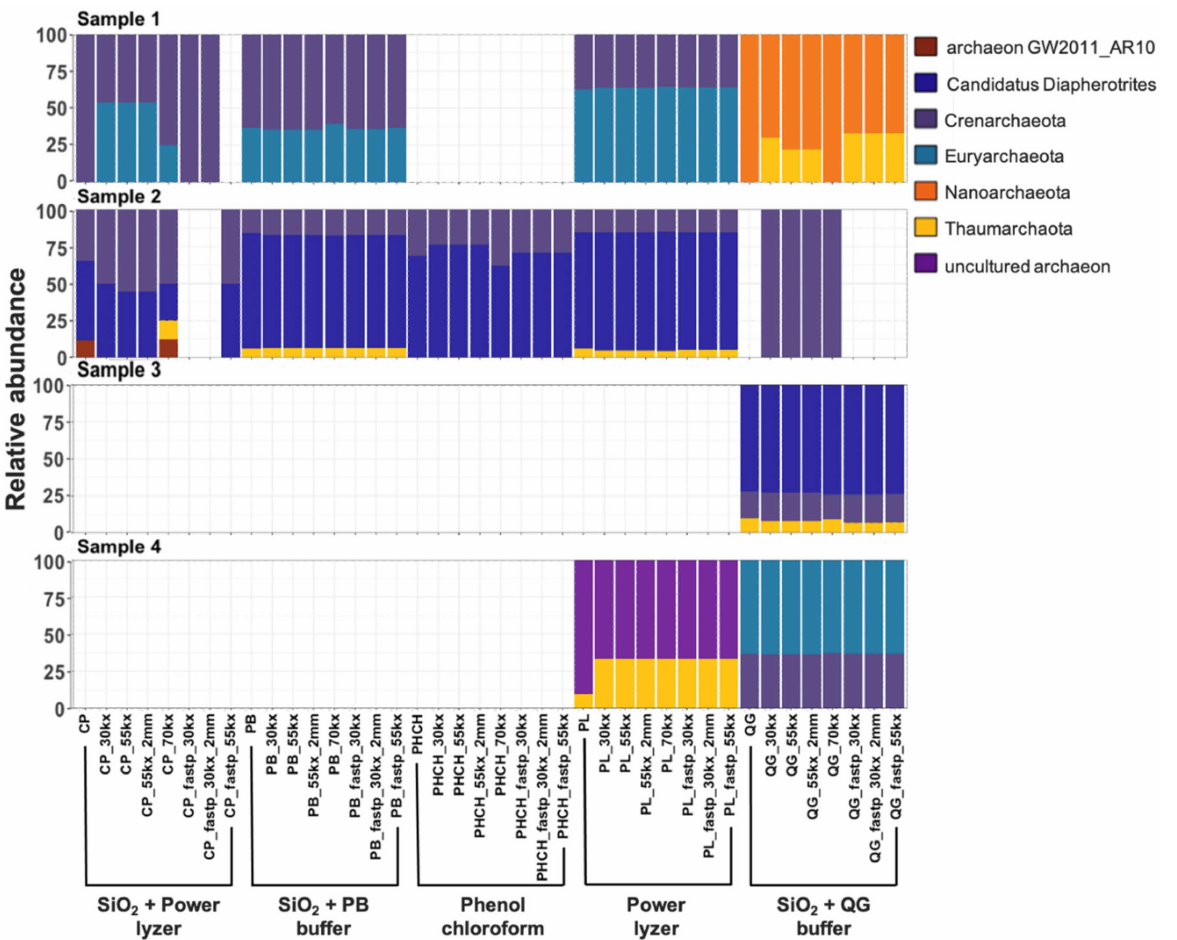
Figure 3. Taxonomic profile for the Archaea domain at phylum level of collapsed reads of the four samples extracted with five DNA extraction methods and preprocessed using eight bioinformatic pipelines, obtained by aligning collapsed reads to SILVA SSU 132 as reference